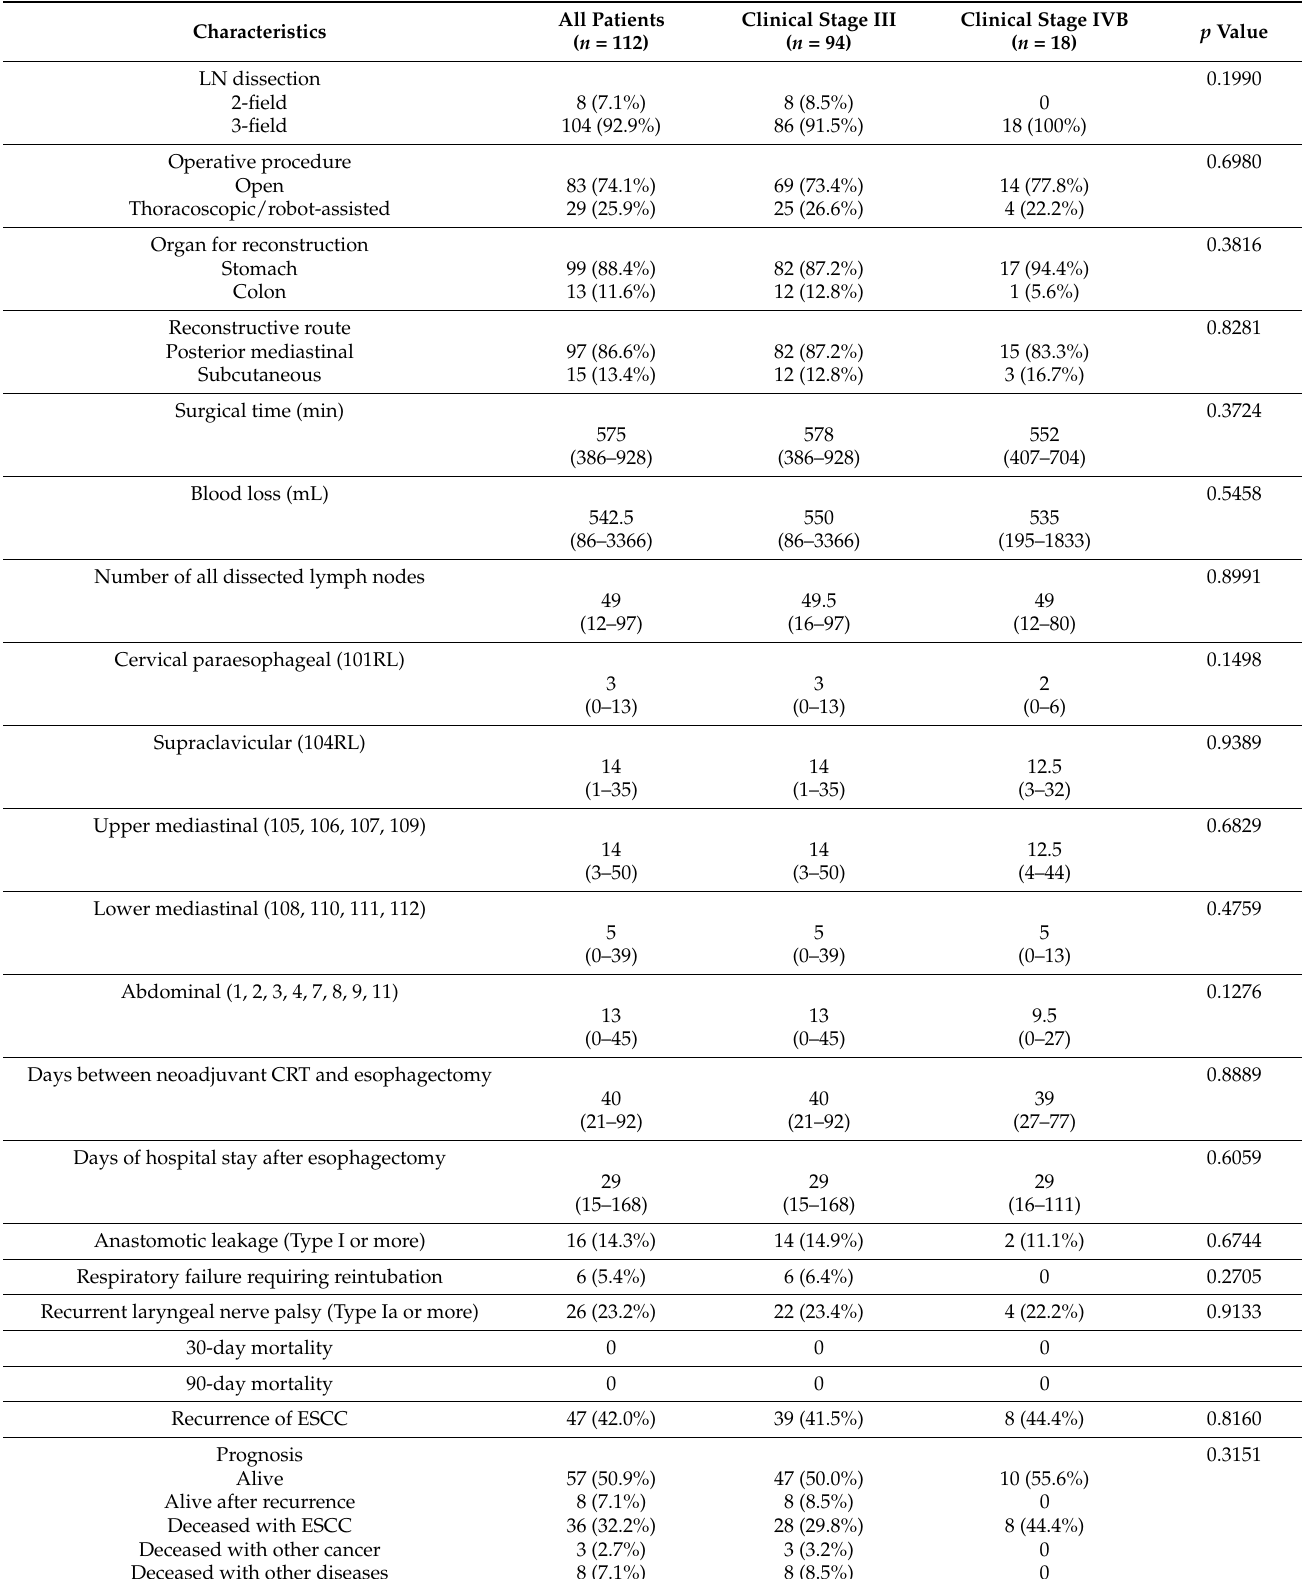
Table 4. Esophagectomy, complications, and prognoses for all 112 ESCC